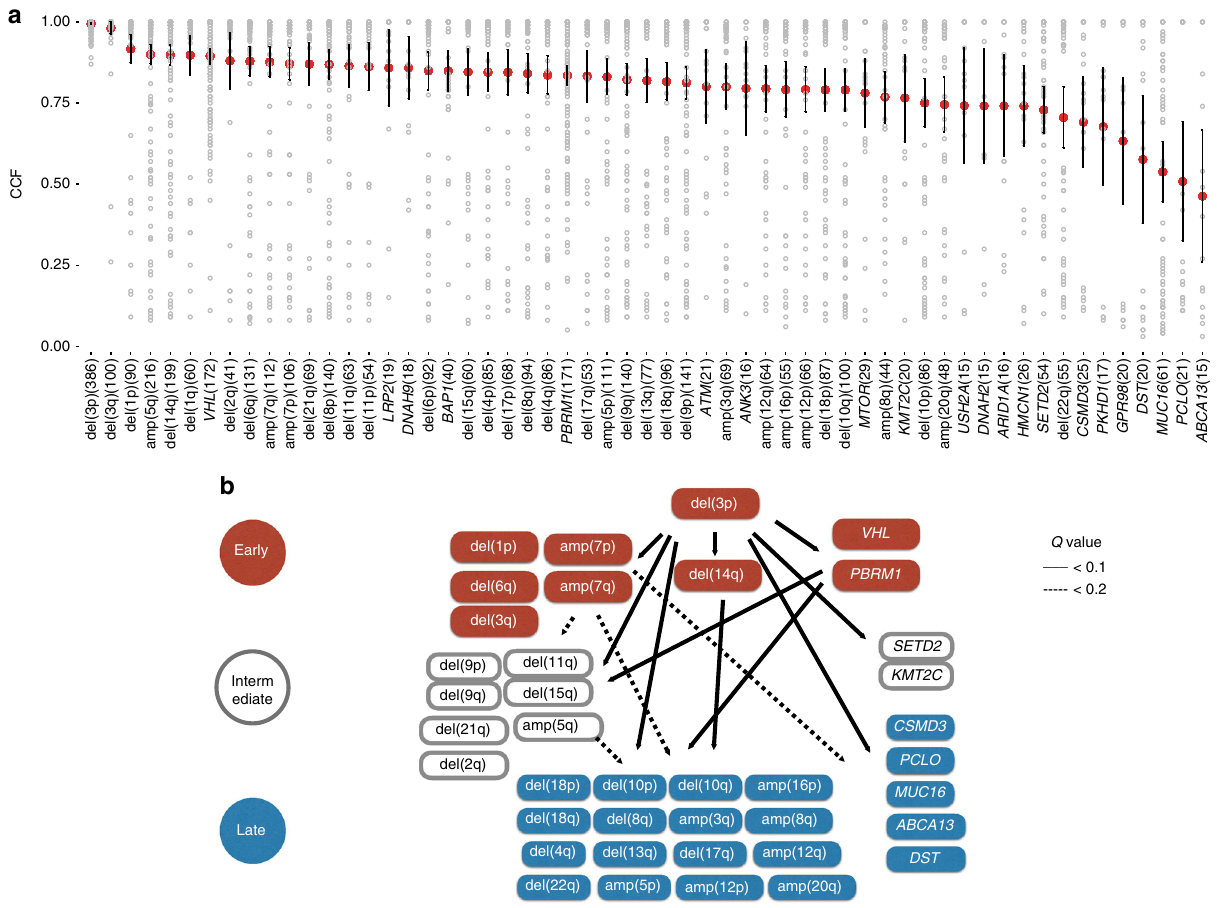
Fig. 3 The temporal order of mutation acquisitions during ccRCC evolution. a The distributions of cancer cell fraction (CCF) values for the frequent somatic events. The median CCF value is shown for each gene or SCNA (red dots represent the medians and bars represent 95% con fi dent intervals). b The temporal maps of mutation acquisitions in ccRCC. Temporally direct edges are drawn when two drivers are found in the same sample, one in clonal and the other in subclonal. Only driver pairs with at least fi ve connecting edges were tested for statistical signi fi